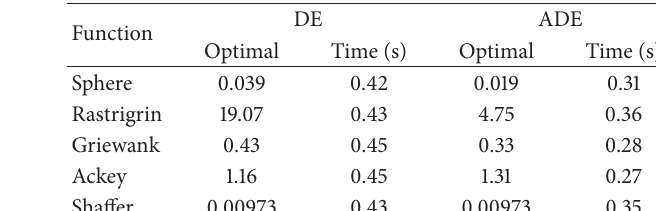
Table 2: The performances of DE and